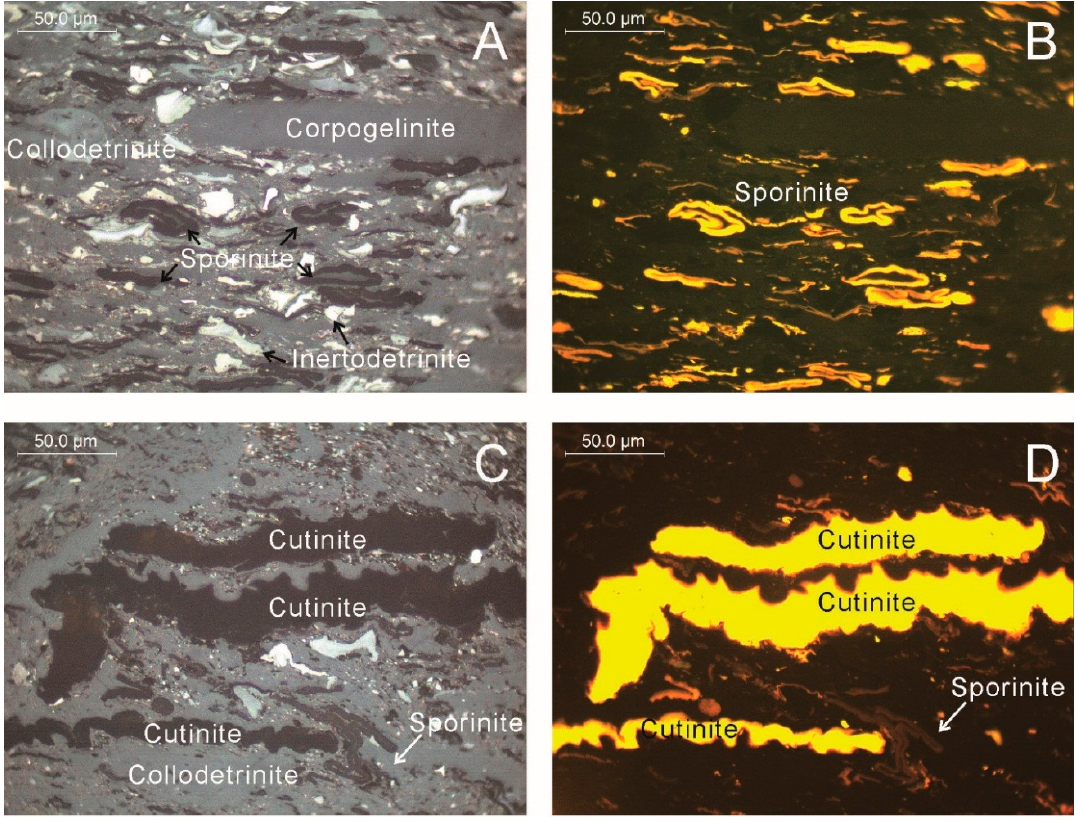
Figure 5. Cont. Figure 5. Cont.